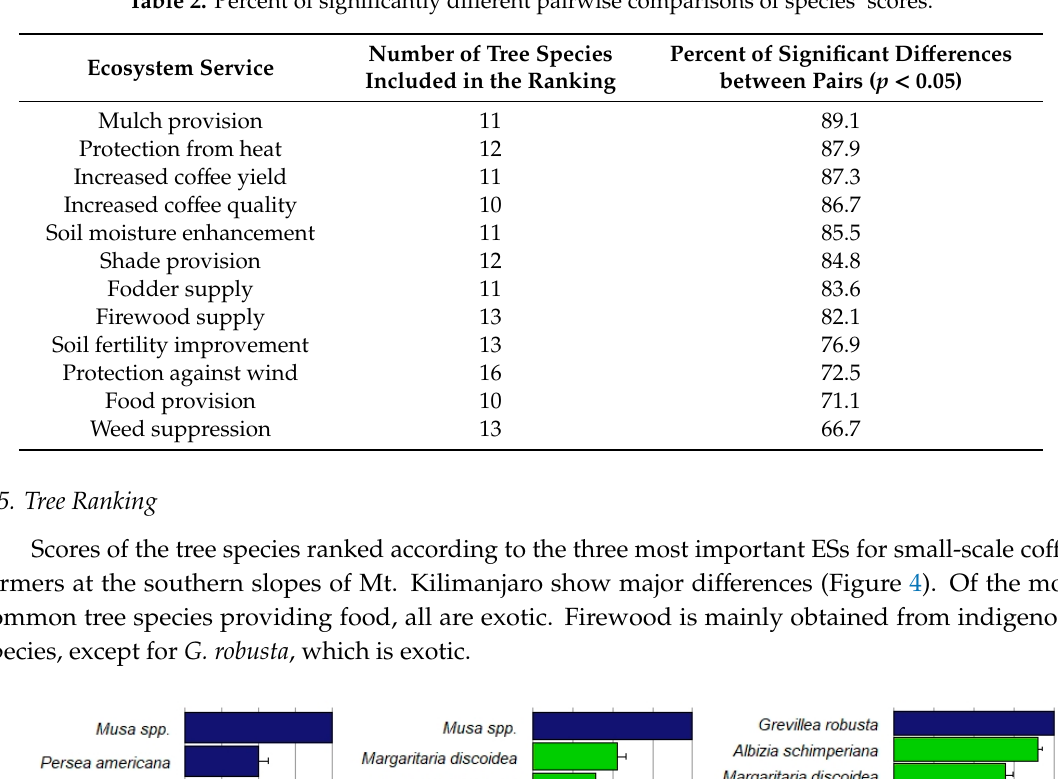
Table 2. Percent of significantly different pairwise comparisons of species' scores.